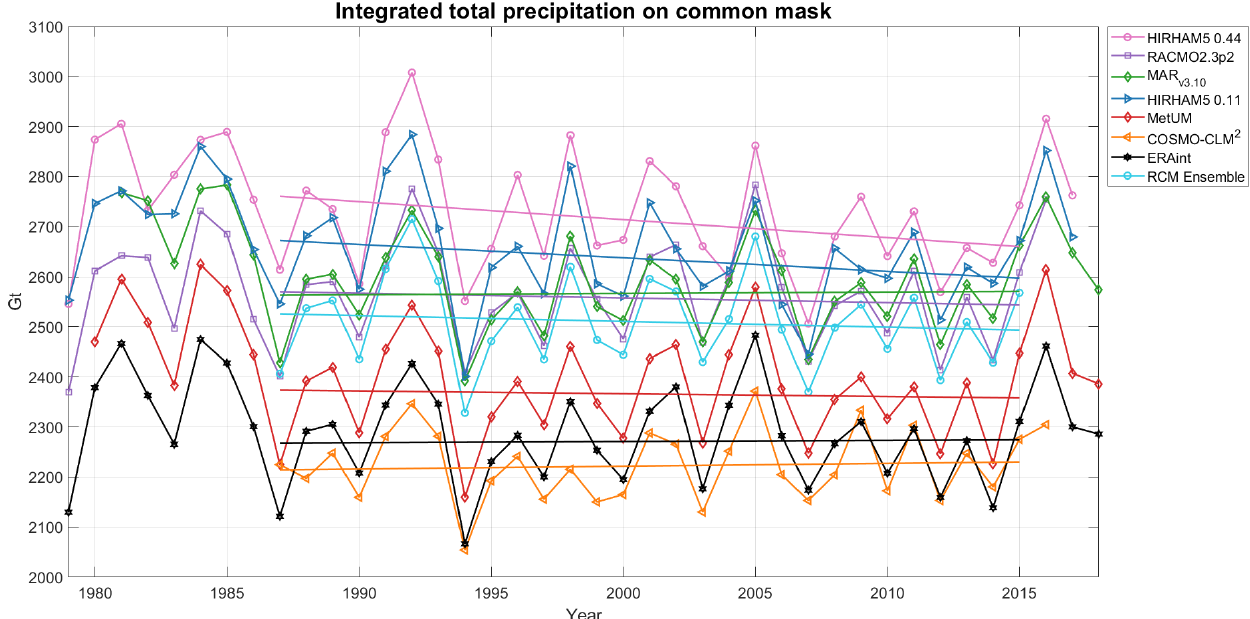
Figure 9. Annually resolved precipitation integrated over the common mask for the different RCMs in the period 1979–2018. All RCMs use ERA-Interim. The ensemble is a mean calculated from all five RCMs in the period 1987–2015, where all models have